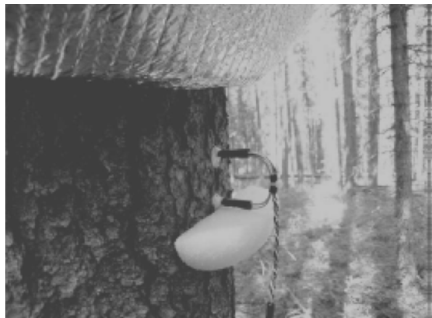
Figure 2. Thermal Dissipation Probes (TDPs) installed in a boreal, coniferous tree with the isolation material (upper part of the picture) ready to cover the sensors and protect them from direct exposure to solar radiation that could affect the sensors’ temperature.